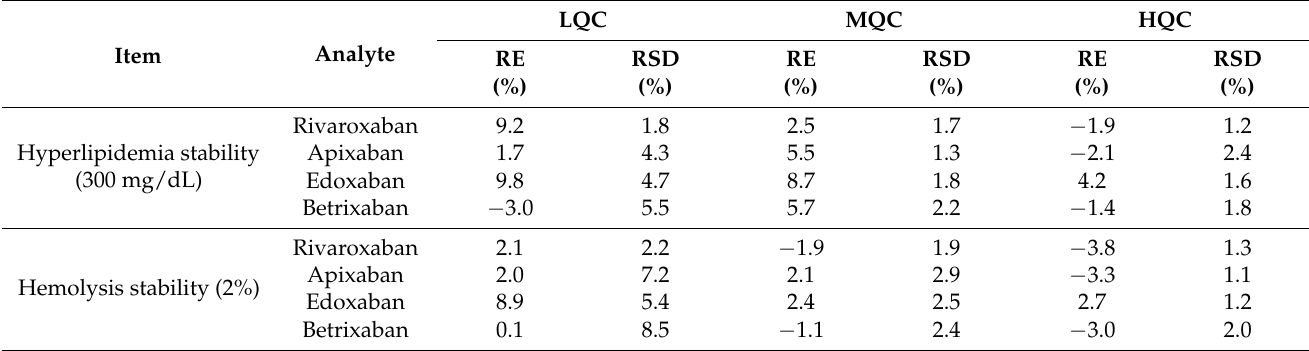
Table 5. Effect of hemolysis and hyperlipidemia in plasma on analytes quantification.